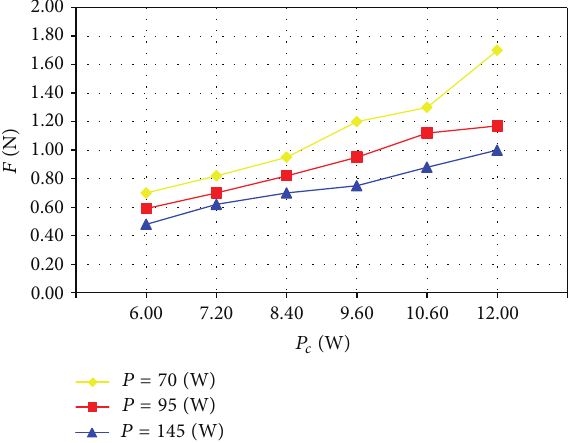
Figure 12: Lateral force variation due to the Coand˘a effect at con- stant values 𝑝 = 8 ∘ and 𝛿 = 2